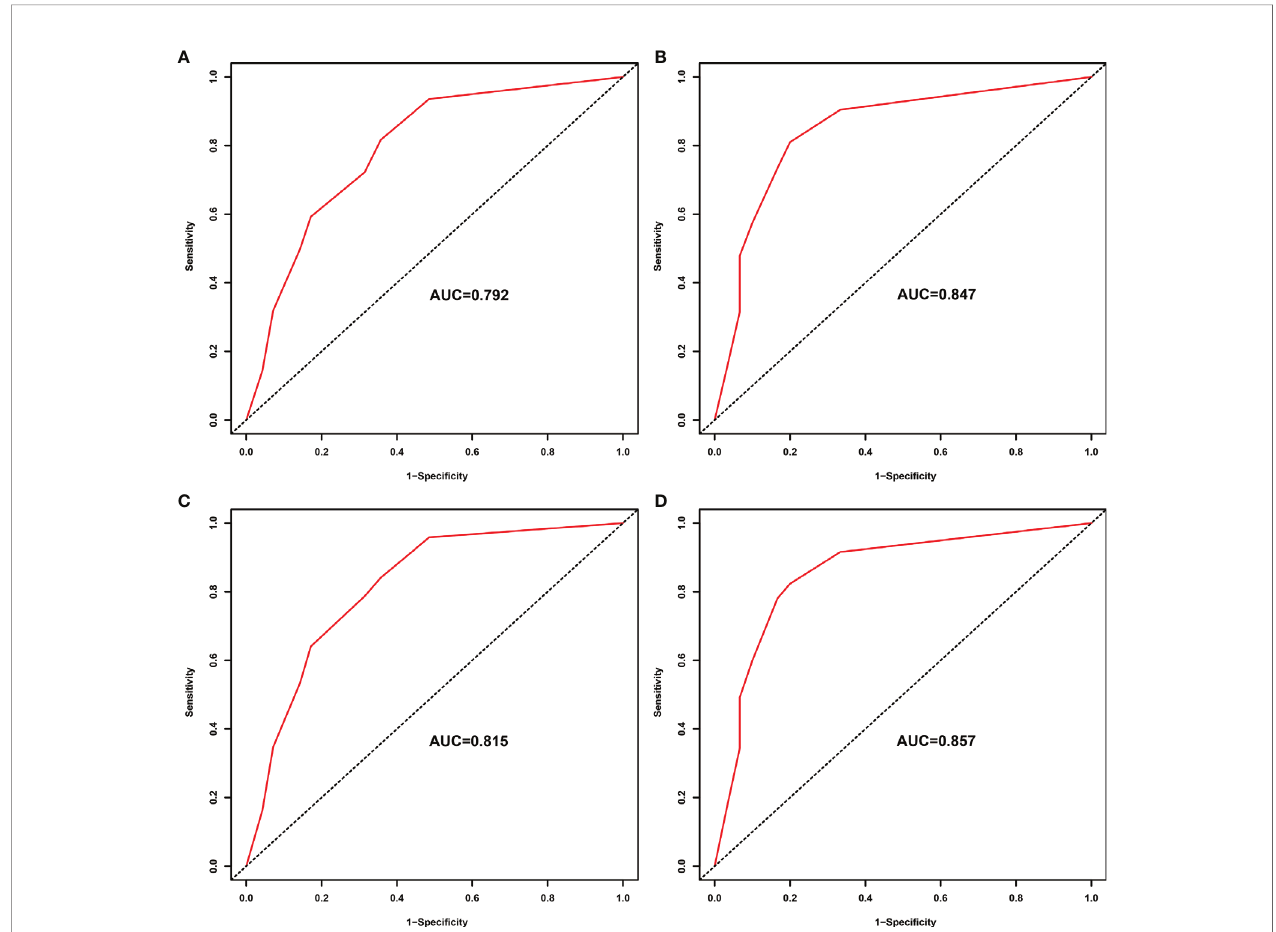
FIGURE 4 | ROC analysis of the prognostic accuracy of nomogram for 3- year overall survival (OS) (A) , 5-year OS (B) , 3-year DFS (C) , and 5-year DFS (D) . ROC, receiver operating characteristic; OS, overall survival; DFS, disease-free